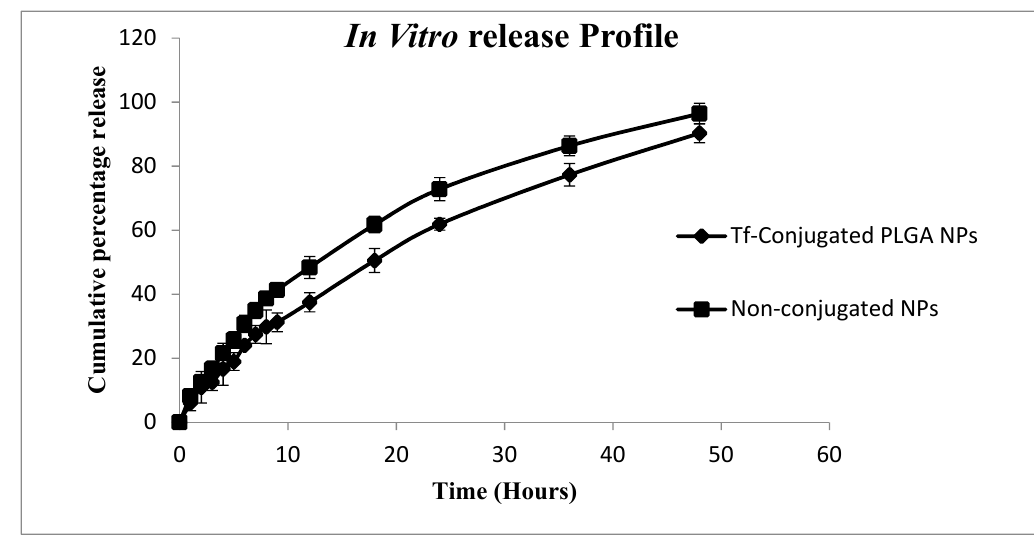
Figure 5. In vitro release profile of DCT ‐ loaded T f ‐ conjugated PLGA NPs and unconjugated nanoparticles.